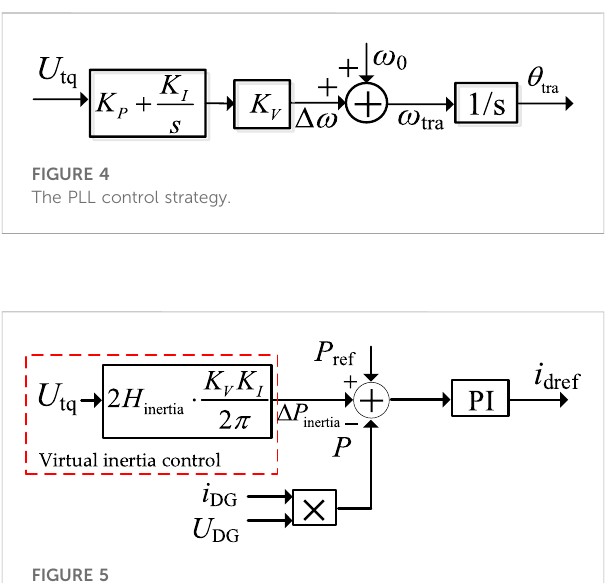
FIGURE 5 The virtual inertia based secondary control method for